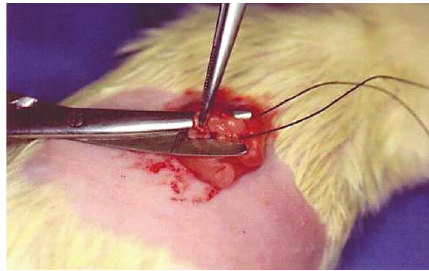
Figure 1: Oophorectomy procedure.